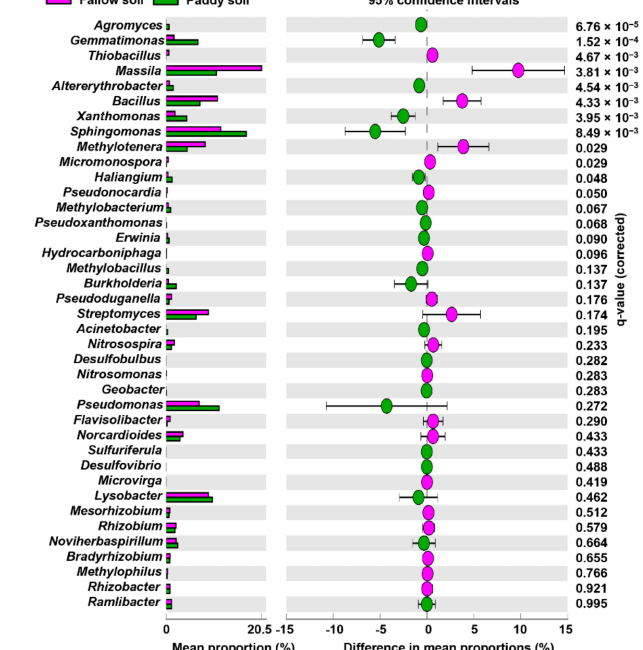
Figure 4. Relative abundances of possible BCAs and pathogenic rice genera. Relative abundance of 39 BCAs and pathogenic rice genera, determined by Welch’s t -test with a Benjamini–Hochberg FDR test correction to calculate q